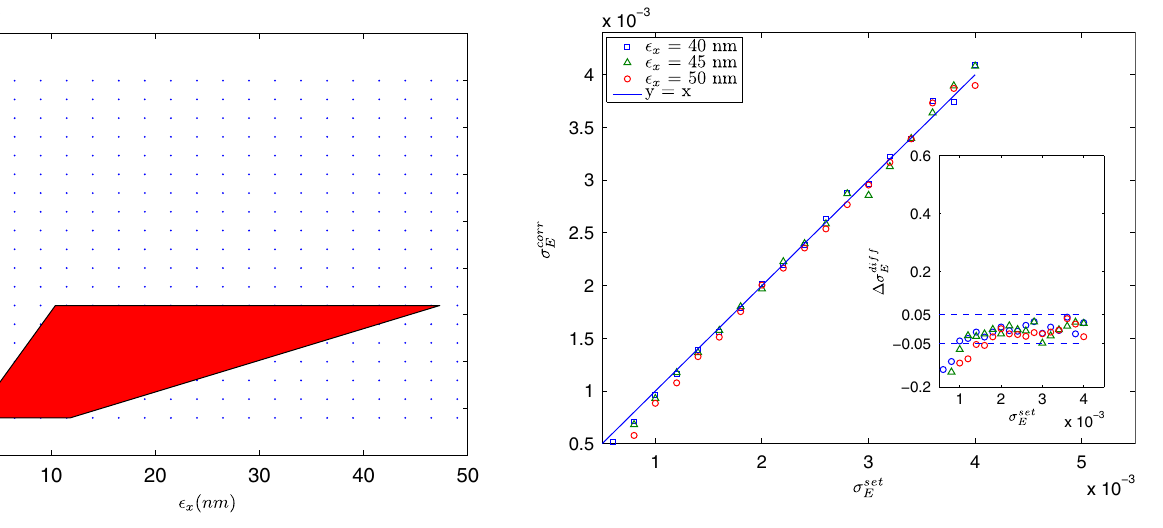
, as a ;(cid:3) x . (cid:1) E is x ;(cid:3) x